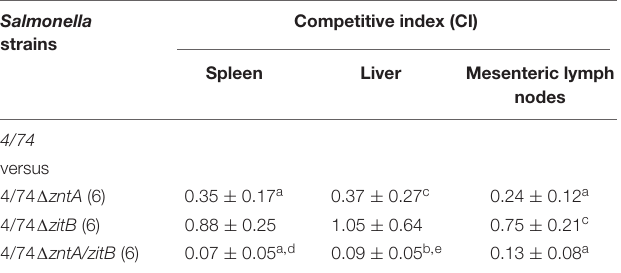
TABLE 2 | Competitive indices for S. Typhimurium WT 4/74 versus the derived mutants in mice. Salmonella